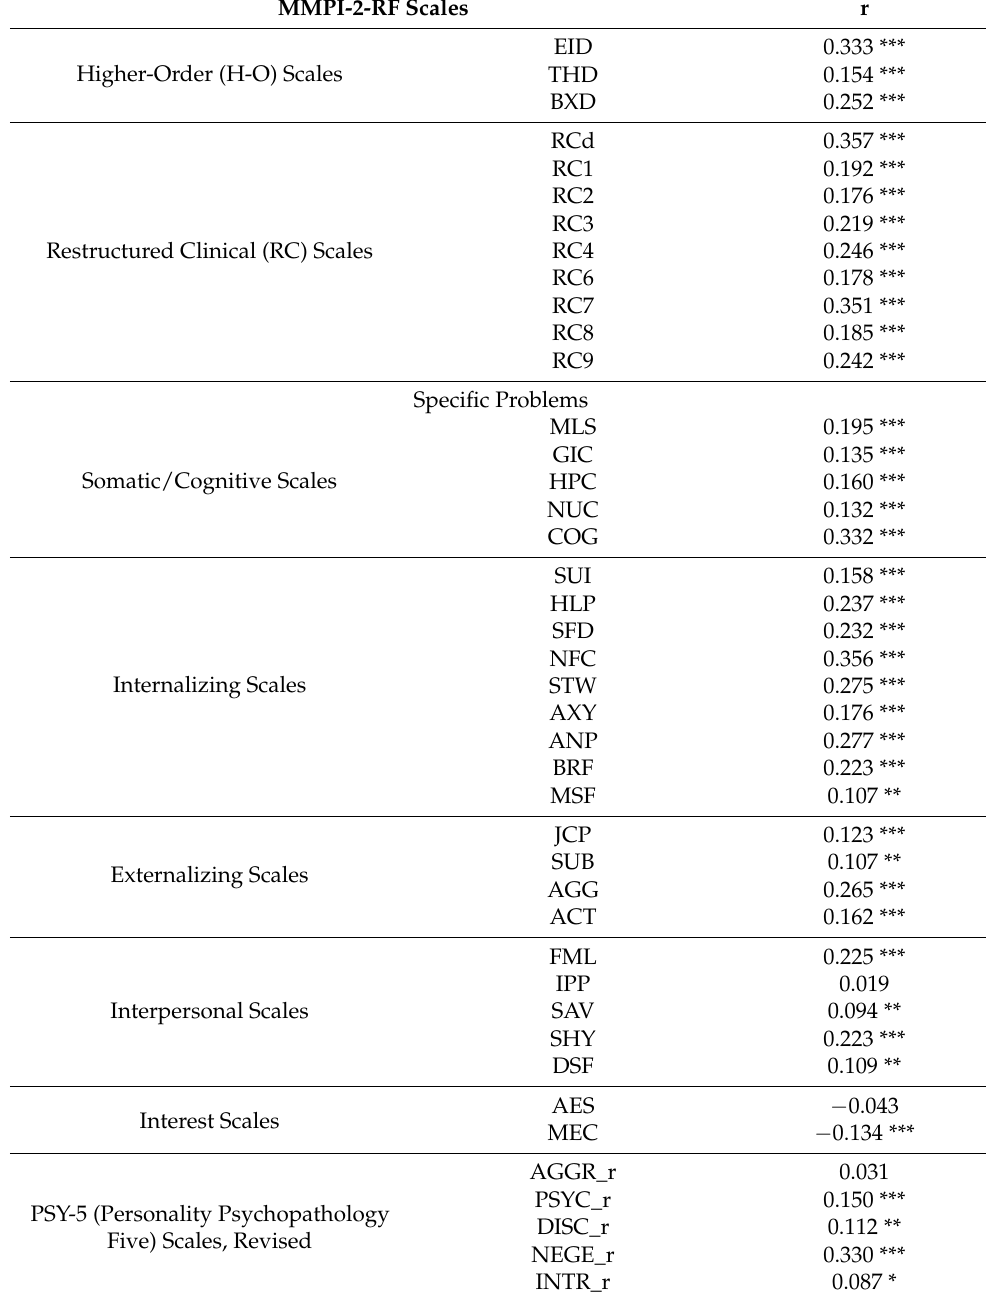
Table 3. Correlation between Smartphone Overdependence Scale Scores and MMPI-2-RF Scale